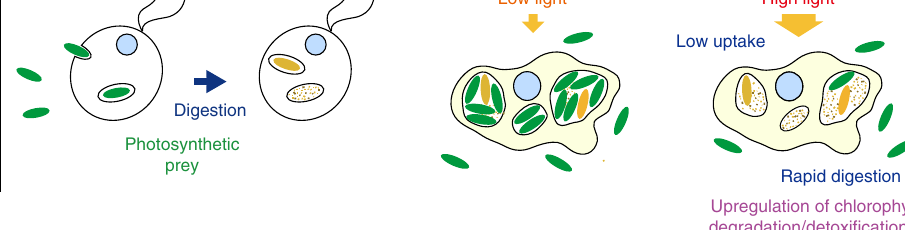
Fig. 7 Comparison of mechanisms to reduce light absorption by photosynthetic apparatus in unicellular predators, eukaryotes accommodating facultative photosynthetic endosymbionts, algae, and plants. When the photosynthetic apparatus absorbs excess light energy, ROS production is elevated. When eukaryotic algae are exposed to high light, they escape from the light by swimming or crawling to reduce light absorption by plastids. When land plants are exposed to high light, the leaf cell changes the positioning of plastids to reduce light absorption by plastids. A reduction in chlorophyll level also occurs in algae and plants to reduce light absorption. Regarding eukaryotes accommodating facultative photosynthetic endosymbionts, when green paramecium is exposed to oxidative stress, they digest algal endosymbionts. When corals are exposed to high light, they remove the algal endosymbionts from the cells. Regarding unicellular predators feeding on algae, when they are illuminated, they reduce their uptake of photosynthetic prey and accelerate their digestion of photosynthetic prey, thus leading to a reduction of photosynthetic prey inside the cells. In addition, PAO-like genes of HGT origin, which are likely involved in degradation/detoxi fi cation, are upregulated upon illumination in the unicellular predators feeding on 6 days. The results showed that several kinds of ameboid organism proliferated in some water samples. Then, for ameboid organisms feeding on unicellular photo- synthetic organisms to proliferate dominantly, the mixture of ameboid organisms was inoculated in BG-11 liquid medium, an inorganic medium widely used for the cultivation of freshwater cyanobacteria 52 , and supplemented with the cyano- bacterium S . elongatus PCC 7942 at 20°C under illumination for 6 days. To isolate respective cells, the culture was serially diluted with BG-11 medium supplemented with S . elongatus in 96-well plates and incubated at 20 °C under illumination. Ameboid organisms that proliferated in the most diluted wells were again subjected to dilution cloning as above. The results showed that four kinds of ameboid organism (based on cellular shapes determined by microscopy) dominated in many wells independently, but one grew very slowly. We isolated clones of the other three kinds and used them for further analyses. To identify the lineages to which the three ameboid organisms belonged, 18S rRNA genes of the three species were ampli fi ed by PCR with the primers MoonA and MoonB 53 . The ampli fi ed DNA was cloned into the pGEM-T Easy vector (Promega) and sequenced. The 18S rDNA sequences were subjected to a BLASTn search against the non-redundant nucleotide sequence database of the NCBI.